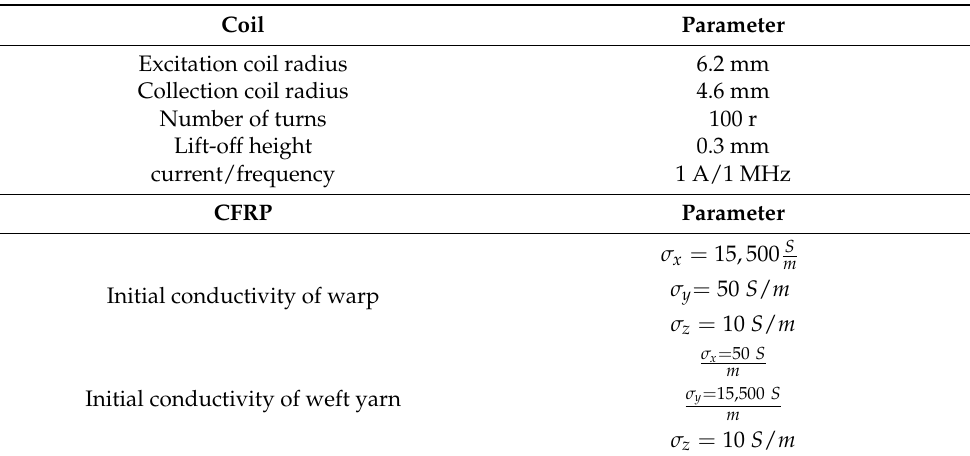
Figure 8. Comparison of the LBC and FBC conductivity models (Load = 500 N). Table 3. Related parameters of the electromagnetic